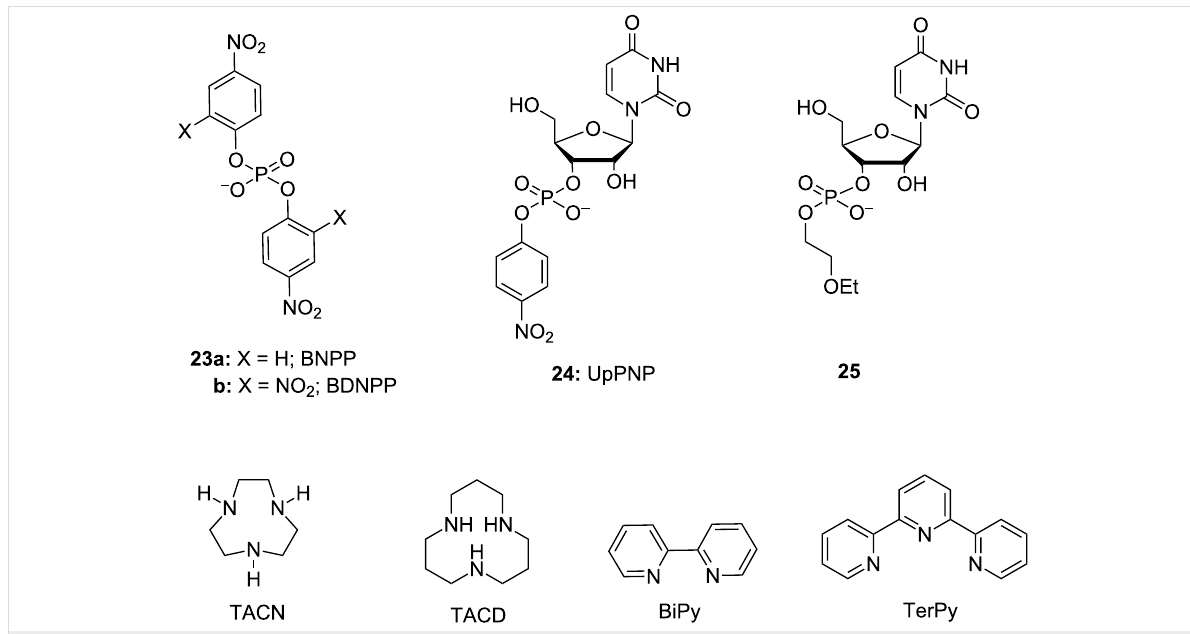
Figure 10: Model compounds ( 23 – 25 ) and metal ion binding ligands used in kinetic studies of metal-ion-promoted cleavage of nucleic acids.